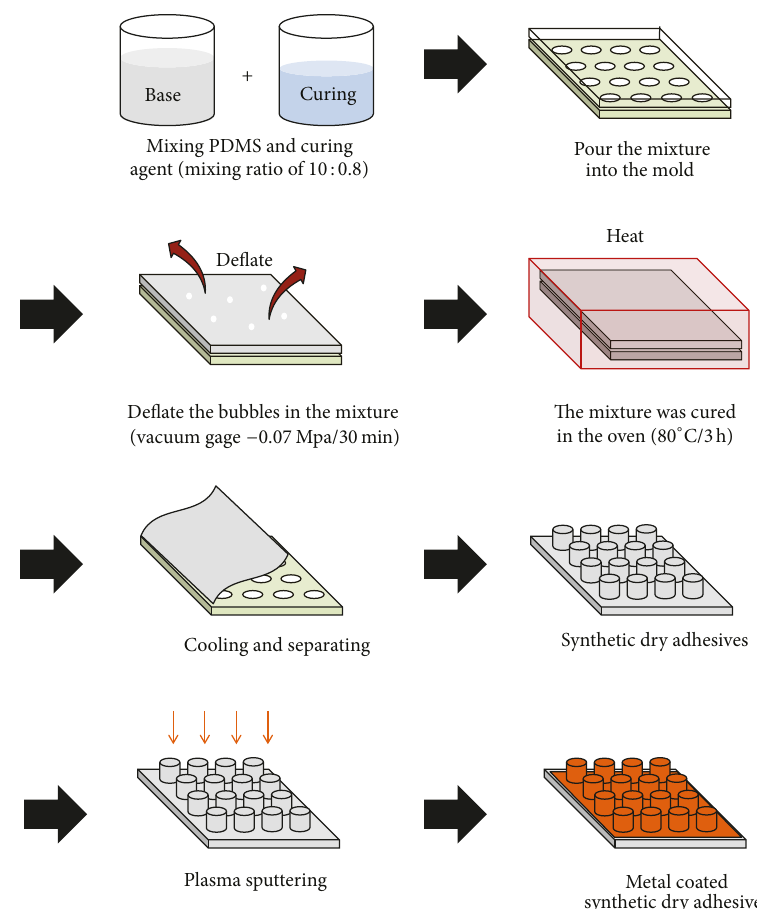
Figure 1: Fabrication process of synthetic dry adhesives coated with metal.